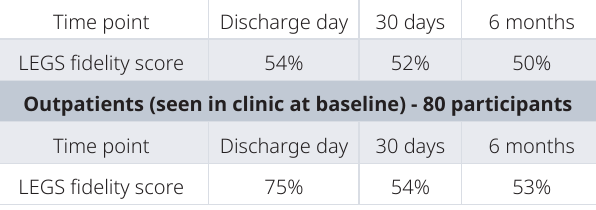
Table 3. LEGS (LEaflet Gp letter Structured checklist) complex intervention fidelity scores at baseline, 30 days, and 6 months (end of prospective